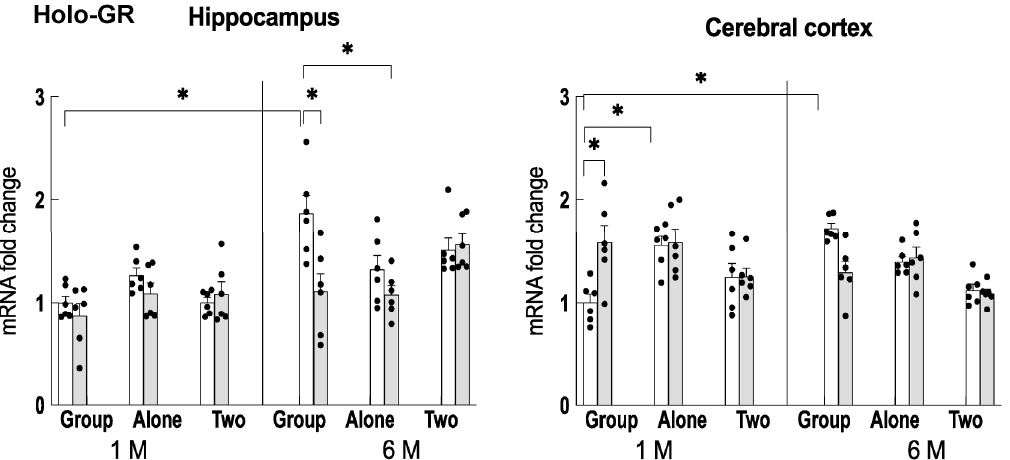
Figure 7. Changes in holo-GR gene expression in the hippocampus and cerebral cortex of mice reared for 1 month (1 M, 2 months old) and 6 months (6 M, 7 months old) in each housing condition. Open column: control mice. Closed column: theanine-ingesting mice. Each column bar represents the mean ± SEM (n = 6) overlaid on scatter plots (* p < 0.05, Tukey’s honestly significant difference method).